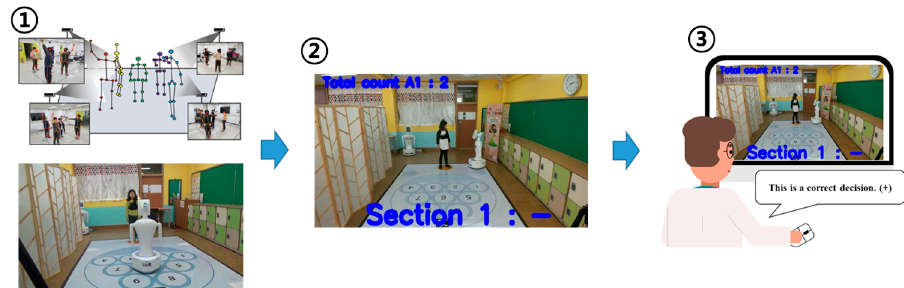
Figure 12. A schematic of the feedback reflection architecture.